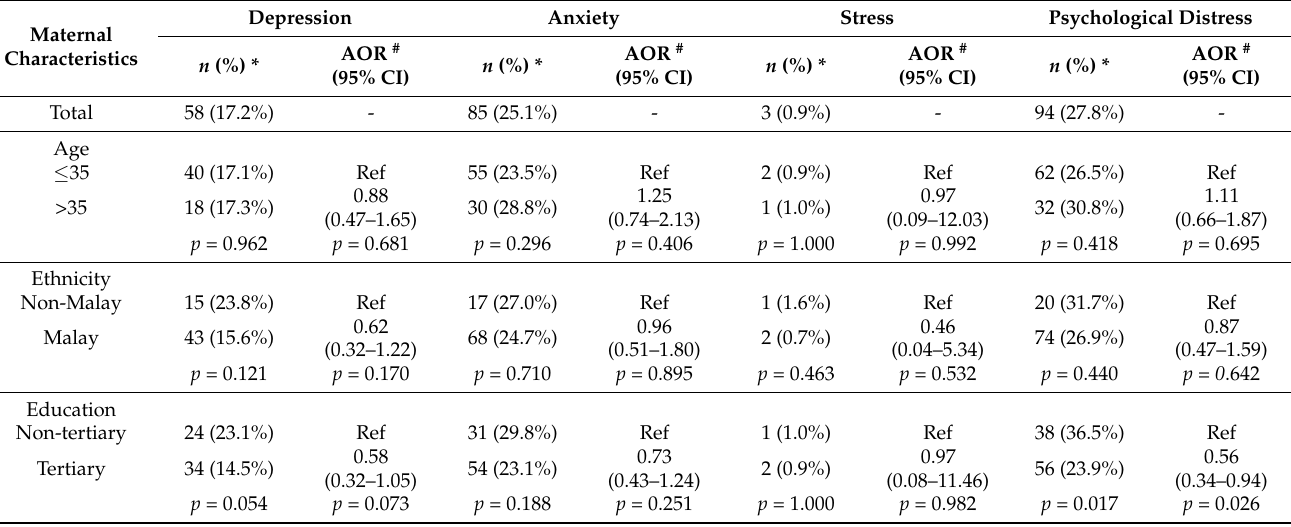
Table 3. Associations between maternal characteristics and depression, anxiety, stress and psychological